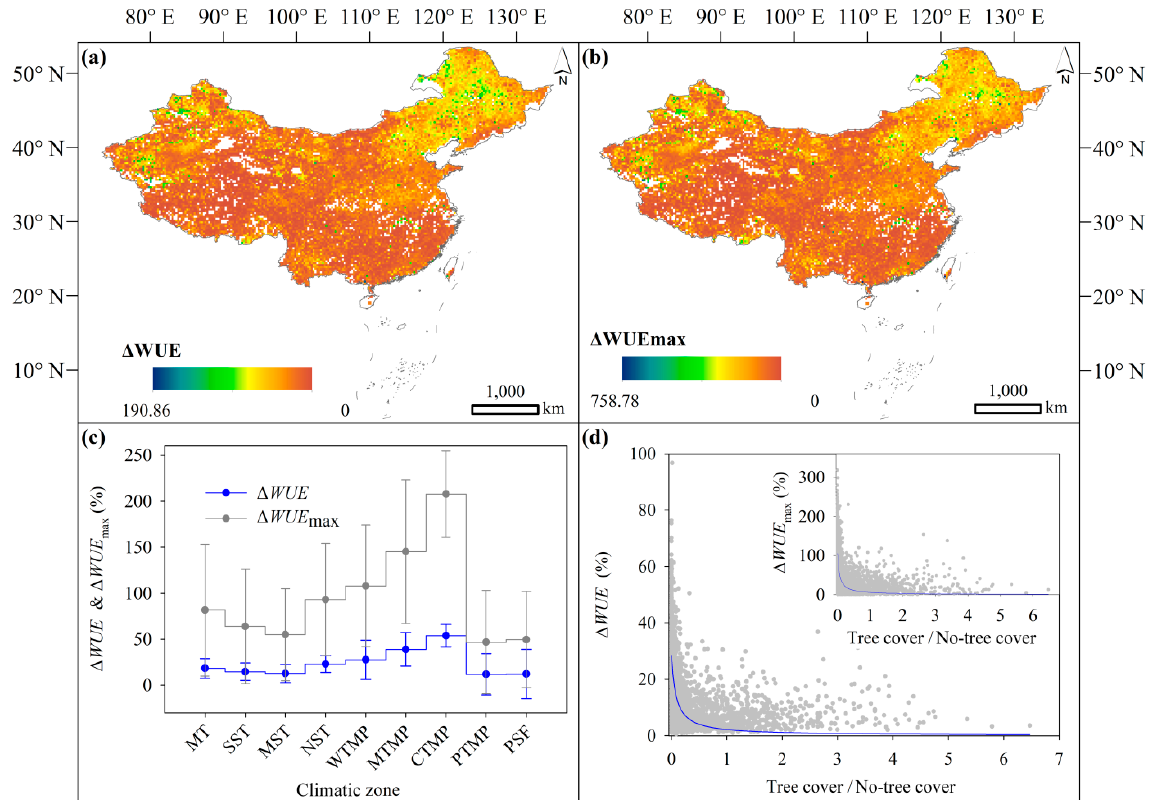
Figure 5. Percentage change in water use efficiency ( Δ WUE ) caused by soil moisture variation in the terrestrial ecosystem in the growing season. Panels ( a ) and ( b ) represent the spatial variation characteristics of the Δ WUE and ∆ WUE max of the entire terrestrial ecosystem, respectively. Panel ( c ) represents Δ WUE and ∆ WUE max in different climatic zones. Panel ( d ) shows the scatter plot between the variation in WUE and the ratio of tree cover to no-tree vegetation cover. The abbreviations of MT, SST, MST, NST,WTMP, MTMP, CTMP, PTMP, and PSF represent Marginal tropical zone, south subtropics zone, middle subtropics zone, north subtropics zone, warm temperate zone, middle temperate zone, cold temperate zone, temperate zone in Qinghai–Tibet Plateau and the sub-frigid zone in Qinghai–Tibet Plateau(PSF), respectively.